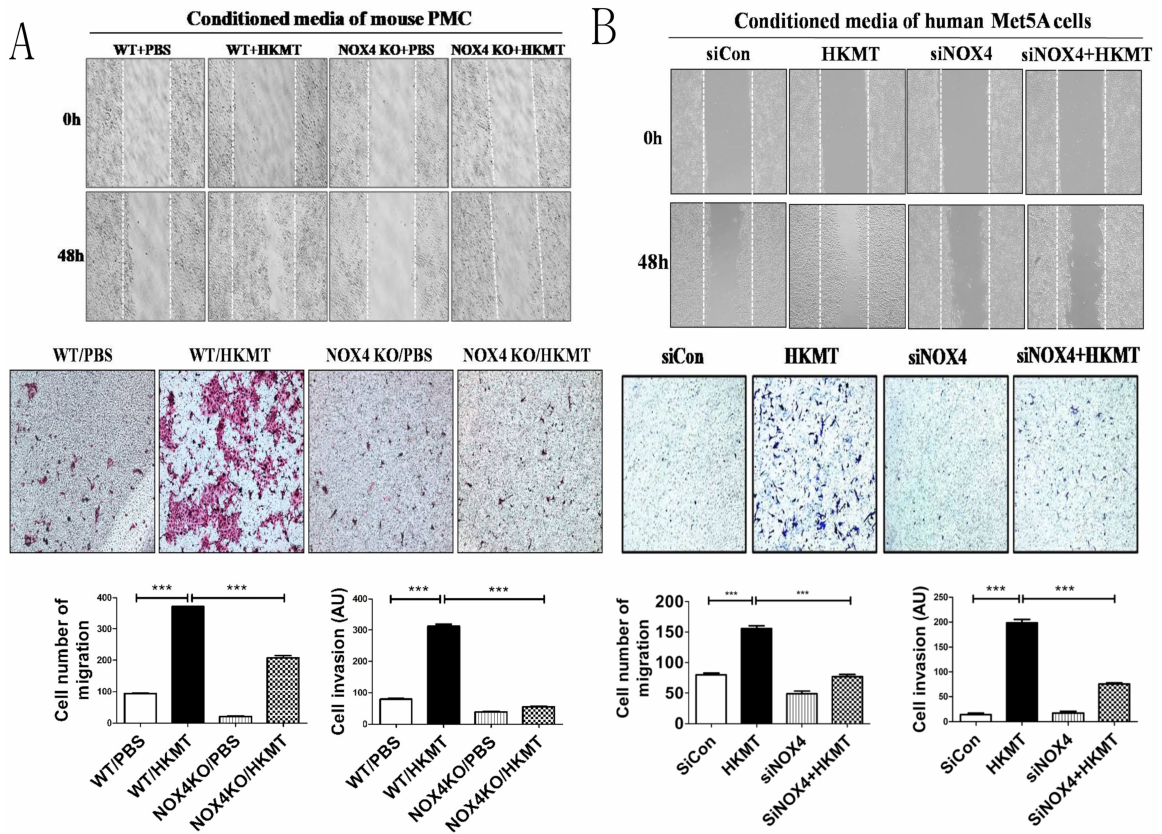
Figure 2. NOX4 regulates tuberculosis-induced lung cancer cell migration and invasion: Scratch-wound healing assay and Transwell assay showed thatNOX4 downregulation significantly prevented the migration and invasion of lung cancer cells. In the Transwell assay, lung cancer cells were platedin the upper chamber containing Matrigel, and the conditioned medium of PMCs (pleural mesothelial cells) with or without HKMT treatment as the chemoattractant in the lower chamber was used for 48 h.( A )Mouse model: mouse PMCs and KLN205 lung cancer cells were used. ( B ) Human model: human PMC Met5A cells and A548 lung cancer cells were used. Data are presented as the mean ± SEM of at least three independent experiments. *** p <